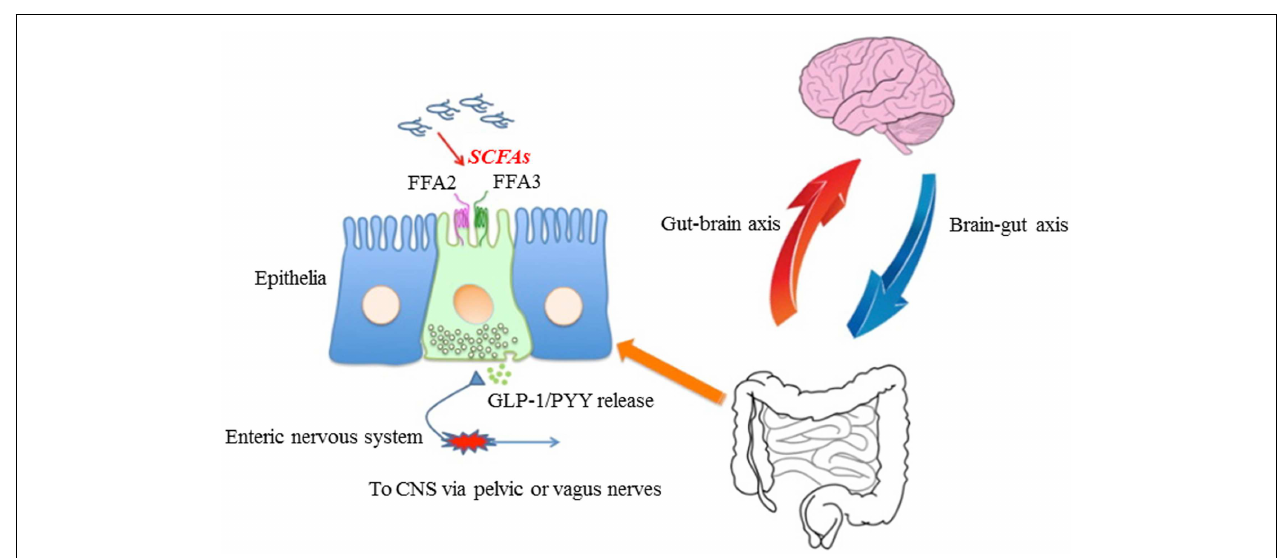
and/or FFA3 located on intestinal epithelia.This activation induces GLP-1 and PYY release into the basolateral side. Released GLP-1 and PYY activate enteric or primary afferent neurons in pelvic and vagal nerves in addition to humoral pathways.These information travel to the CNS, then affect the host metabolic rate to regulate energy